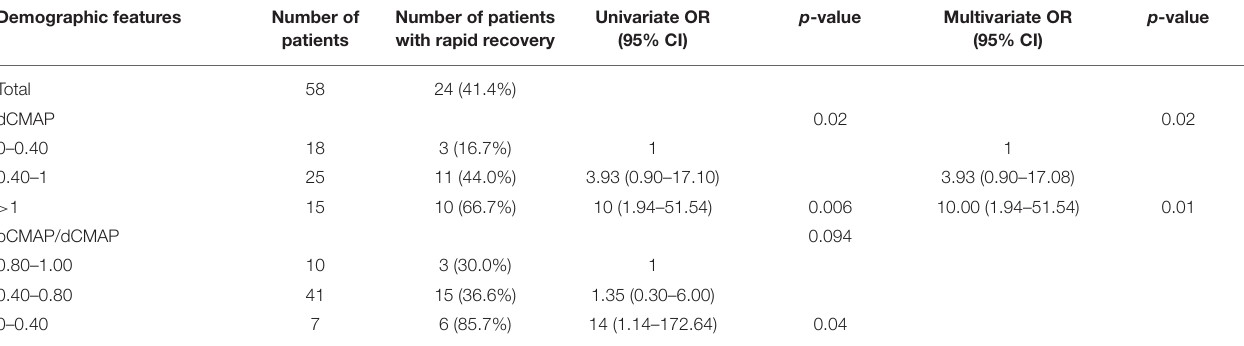
TABLE 5 | Univariate and multivariate regression analyses of factors of rapid recovery in AMAN subtype patients after treatment. Demographic features Number of Number of patients patients with rapid